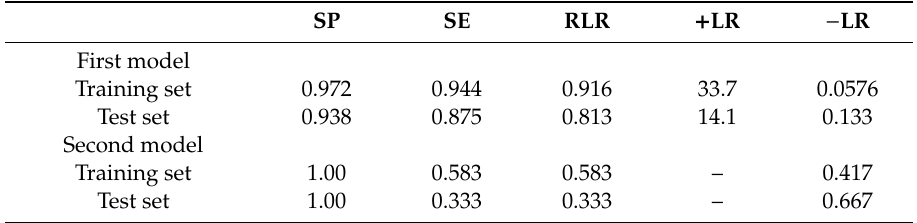
Table 2. Estimated figure of merit (FOM) of the first and second